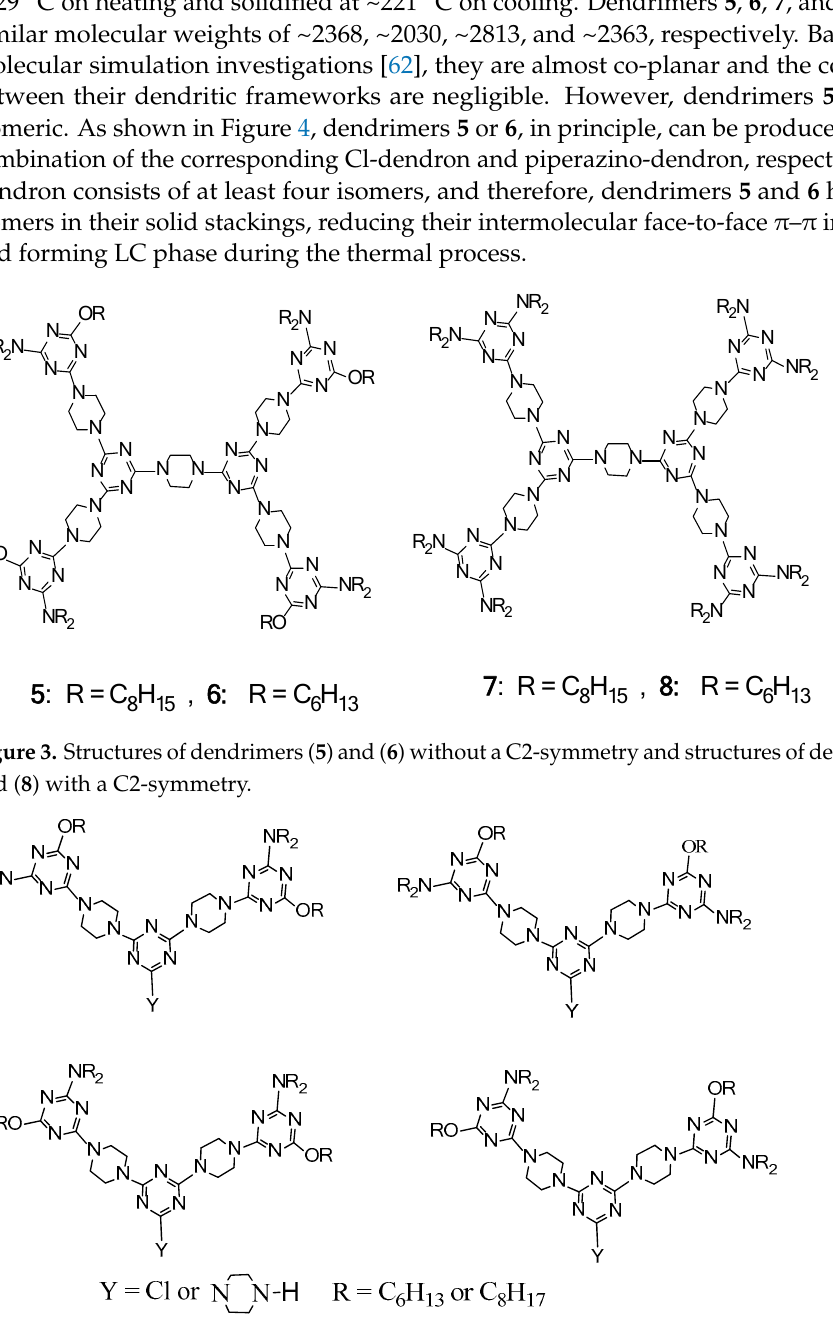
Figure 4. Structural isomers of dendrons to form dendrimers ( 5 ) and ( 6 ).